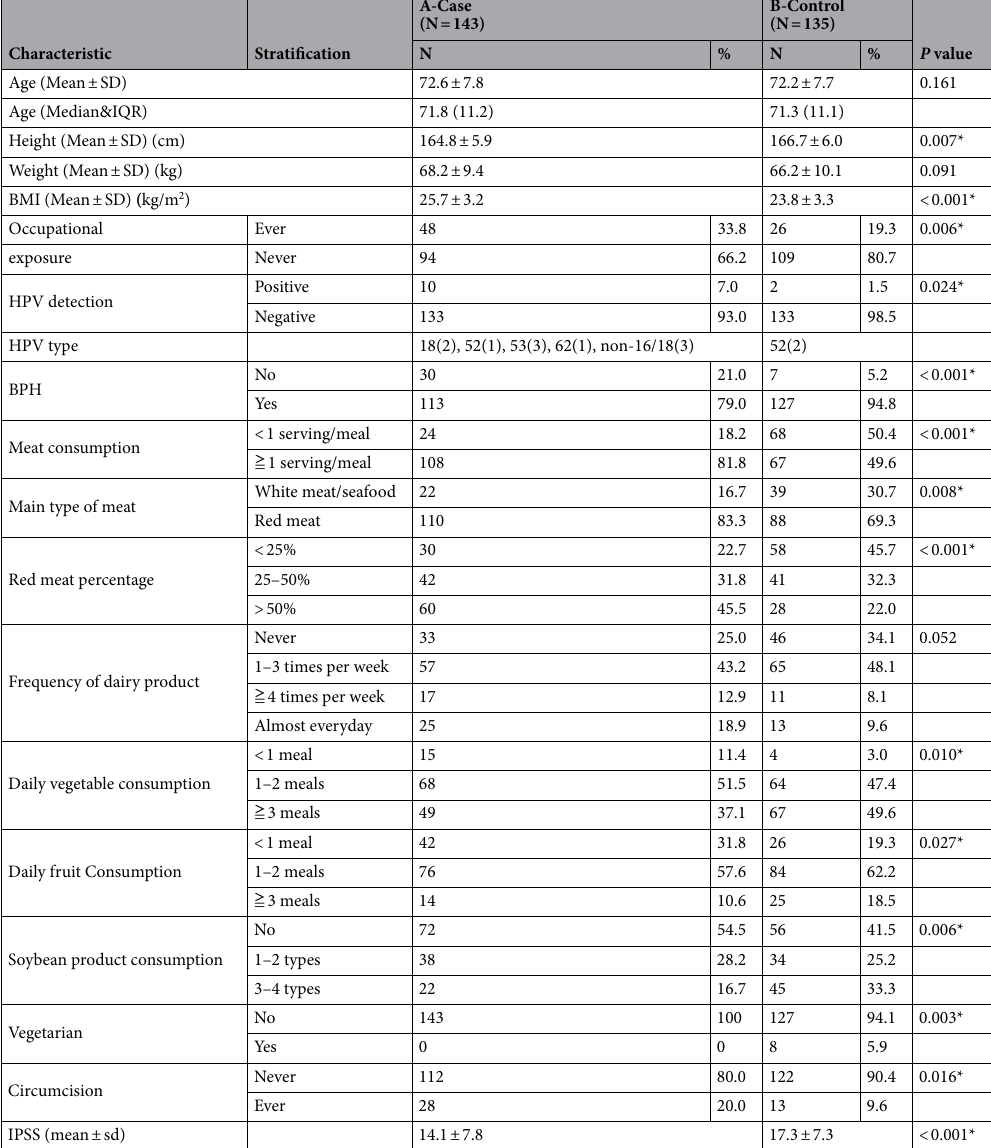
Table 1. Socio-demographic, occupational, personal lifestyles and clinical characteristics. SD standard deviation, BMI body mass index, Univ. university, FT full-time, PT part-time, RET retired, UE unemployed, IQR interquartile range. * P < 0.05; The number in parenthesis ( ) in HPV type denotes case